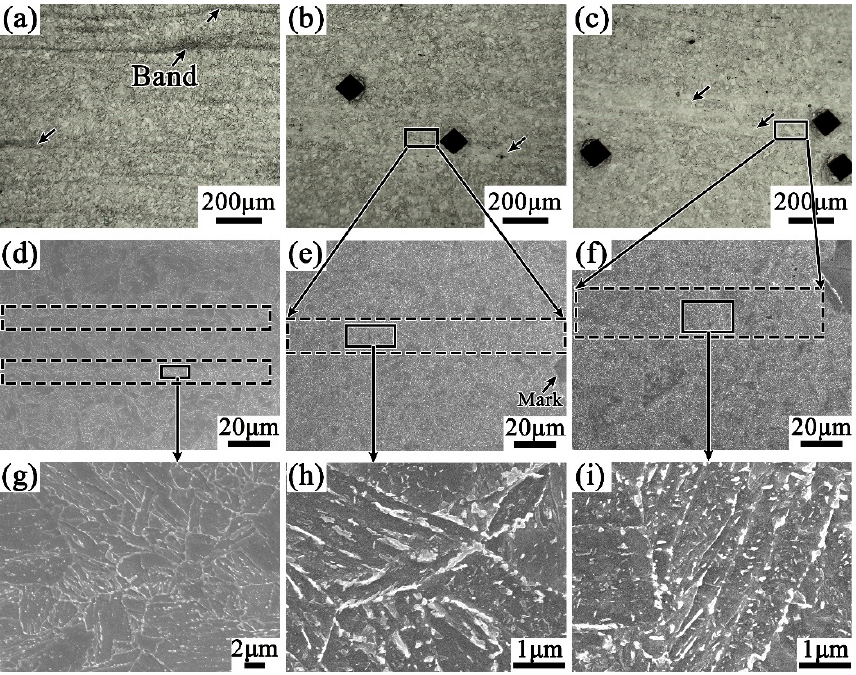
Figure 11. Effect of different heat treatment processes on the carbide banded. Photos downward ( a , d , g ), ( b , e , h ) and ( c , f , i ) correspond to heat treatments QT2, QT3, and QT4 in Figure 1b respectively.